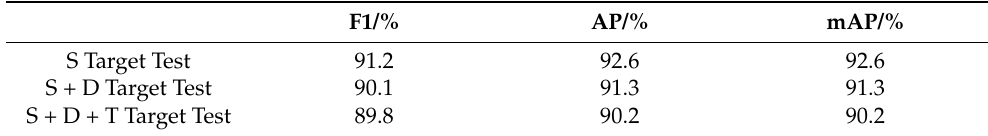
Table 4. Scatter test set performance of the model under simulated grayscale targets.